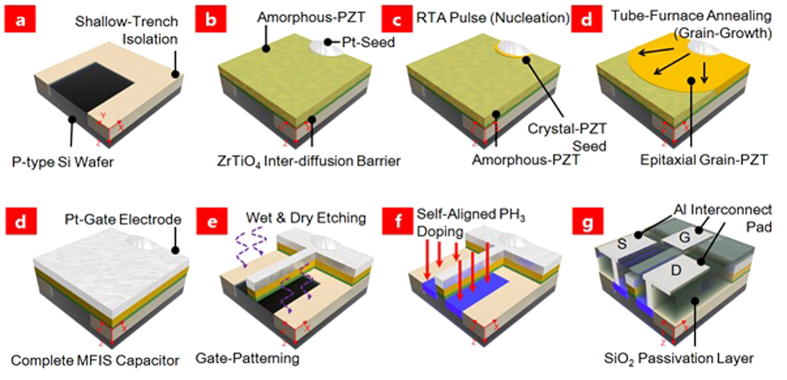
Device fabrication of SNLC-FeFET.(a) Formation of shallow-trench isolation having 400-nm depth of SiO2. (b) Deposition of 2-nm thick ZrTiO4 inter-diffusion barrier, 200-nm thick amorphous-PZT, and 50-nm thick Pt dot. (c) 1-sec pulse of RTA at 700 °C for nucleation seed. (d) 2-hr furnace annealing at 550 °C for epitiaxial grain-growth. (d) Deposition of 200-nm thick Pt gate electrode for MFIS capacitor. (e) Gate patterning process by wet and dry etching process. (f) Self-aligned PH3 doping process at 15 keV of accelerating voltages. (g) Deposition of 500-nm SiO2 passivation layer and Al interconnection contacts.